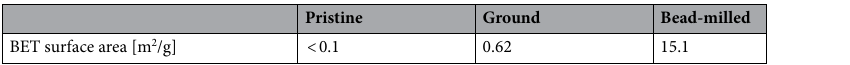
Table 2. BET surface area from gas adsorption measurement.